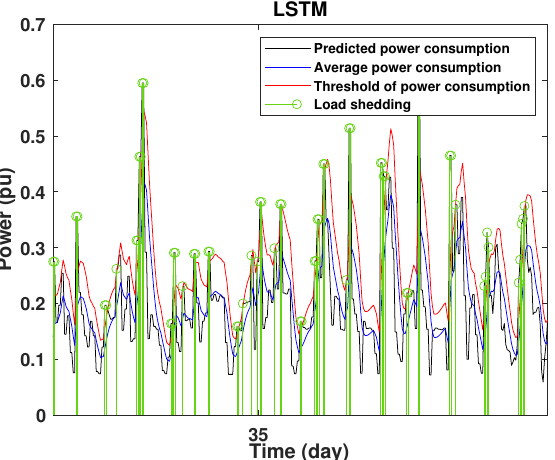
Figure 23. Detection of power consumption peaks during 3 days using the LSTM model.